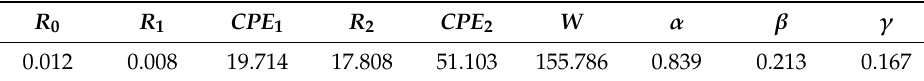
Table 5. Fractional-order model (FOM) parameter identification results.